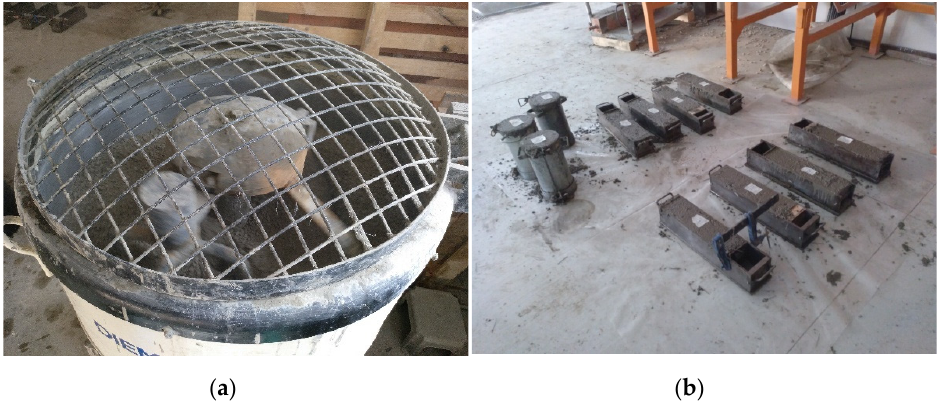
Figure 2. ( a ) Production of concrete and ( b ) specimens produced in a batch of this program.